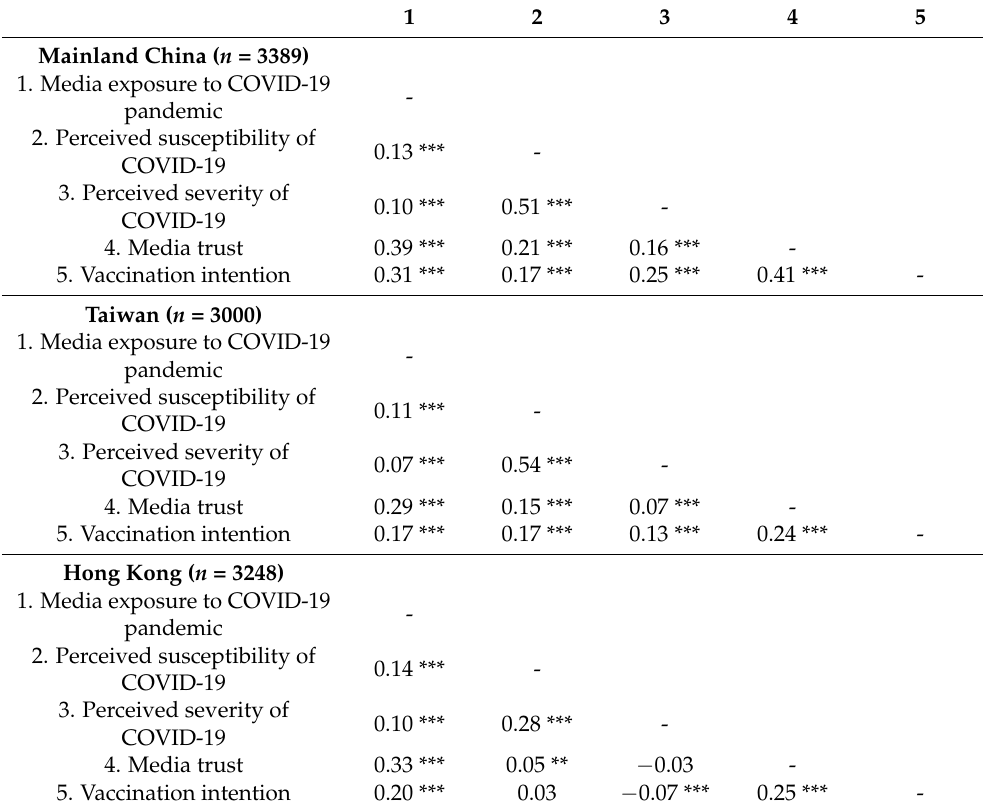
Table 2. Correlation among study variables in three Chinese